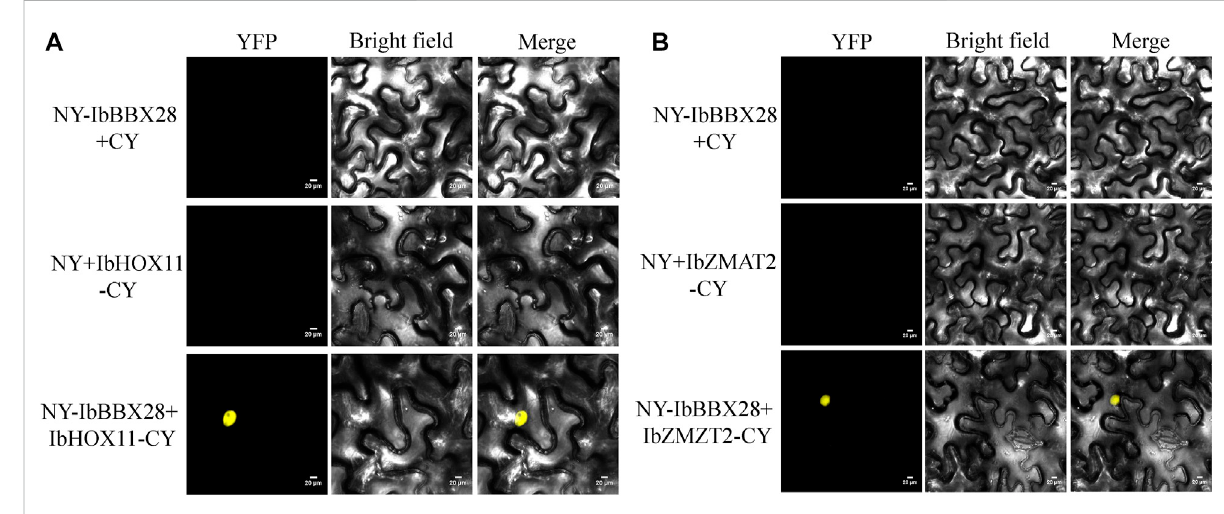
FIGURE 8 BiFC validation of the IbBBX28 interacting protein. (A) BiFC assay of IbBBX28 with IbHOX11. (B) BiFC assay of IbBBX28 with